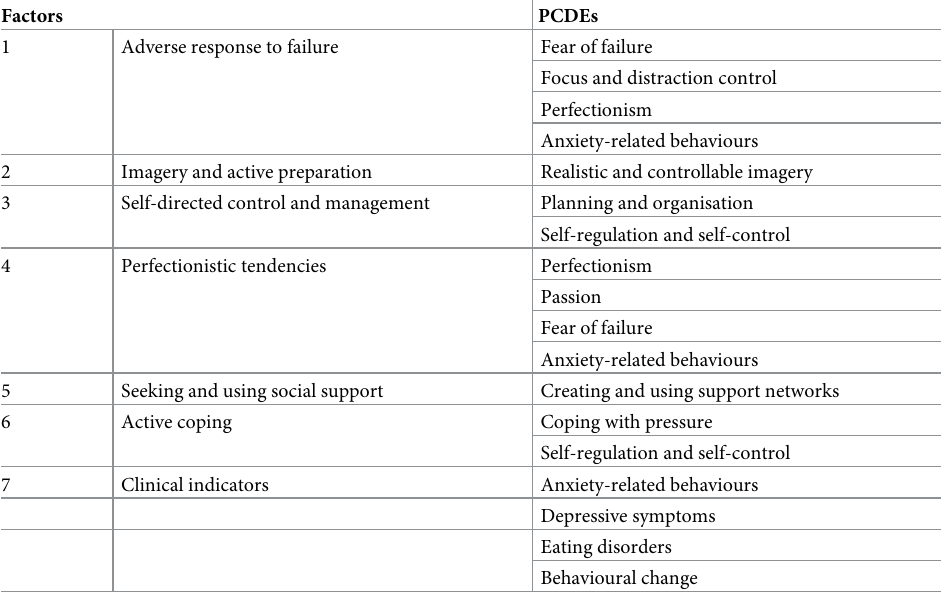
PCDEs: Psychological Characteristics of Developing